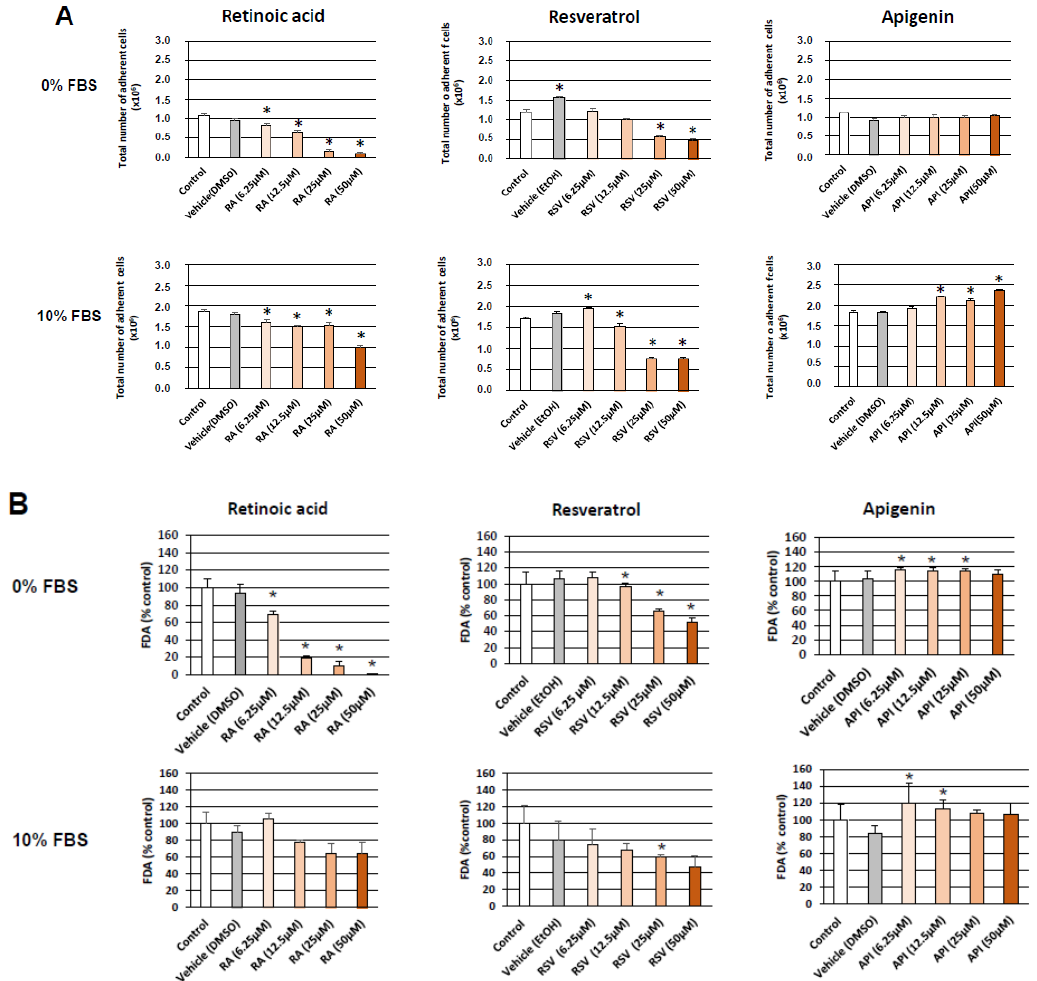
Figure 3. Incidence of neuronal differentiation induced by resveratrol and apigenin on cell growth and viability of N2a cells. Murine neuronal N2a cells previously cultured for 24 h in conventional cultured medium were further cultured for 48 h in medium without and with 10% FBS in the absence or in the presence of retinoic acid (RA: 6.25–50 µ M) used as positive control for the induction of neuronal differentiation, or with polyphenols: resveratrol (RSV: 6.25–50 µ M) and apigenin (API: 6.25–50 µ M). Control cells were cultured in medium without and with 10% FBS. Two vehicle controls were realized: EtOH used with RSV, and DMSO used with RA and API. Cell growth (total number of adherent cells) was determined by cell counting ( A ) and cell viability by fluorimetry with the FDA test ( B ). Each value is the mean ± standard deviation (SD) of four independent experiments. An ANOVA test followed by a Mann–Whitney test were used. p values of 0.05 or less were considered as statistically significant. * comparison between control (untreated cells), vehicles (DMSO, EtOH), and RSV, API and RA; no difference between control/vehicles (DMSO, EtOH) was observed.